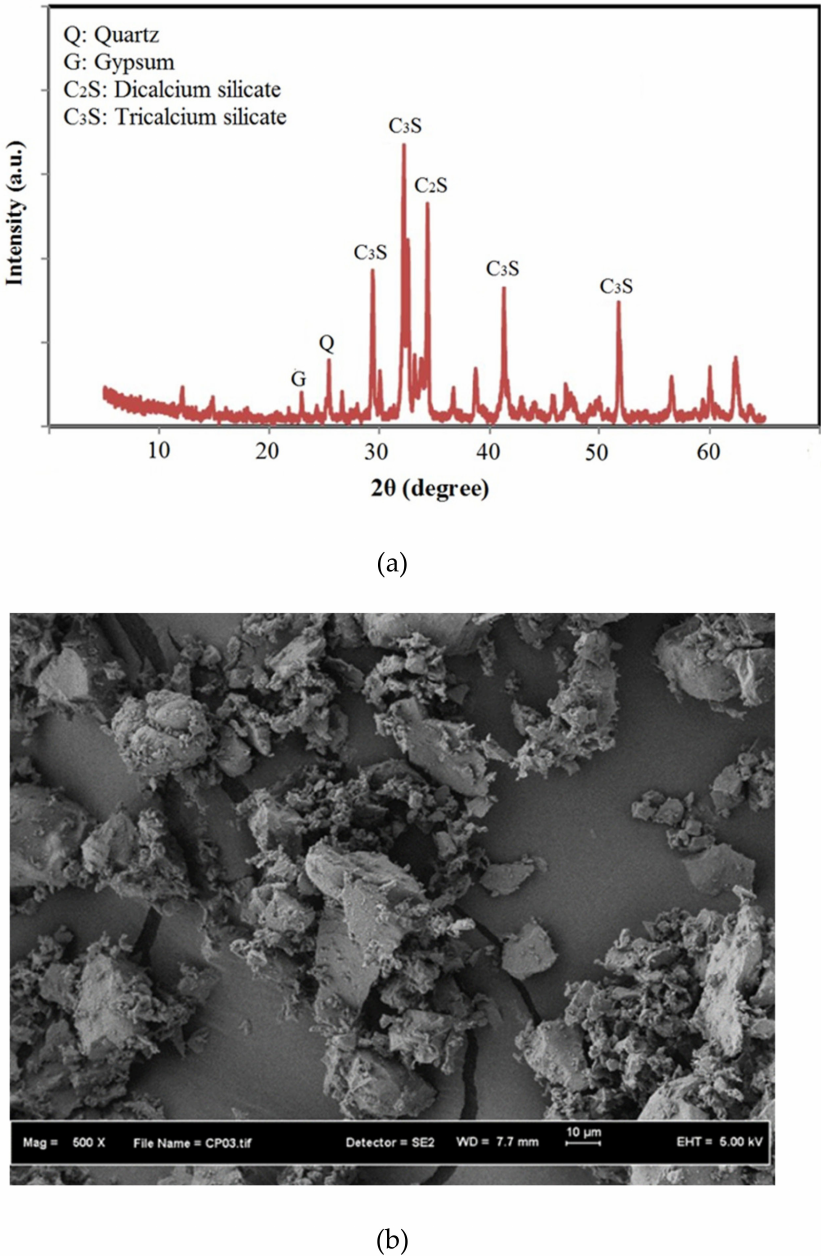
Figure 3. Mineral properties of OPC powder ( a ) XRD pattern and ( b ) SEM